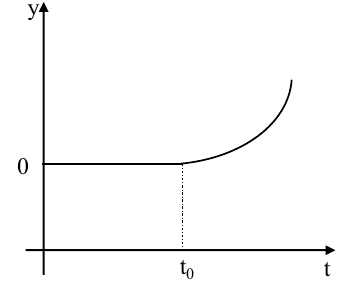
Figure 2. Schematic Diagram of Linear Soft Fault.